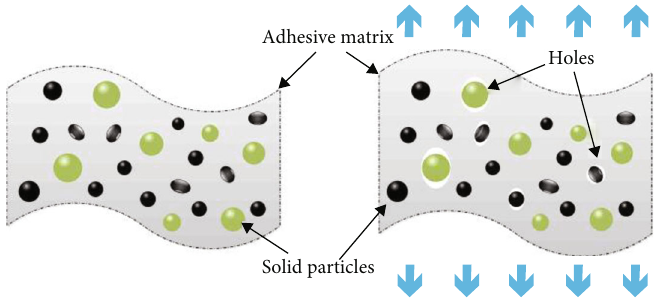
Figure 7: Schematic diagram of the propellant microstructure.